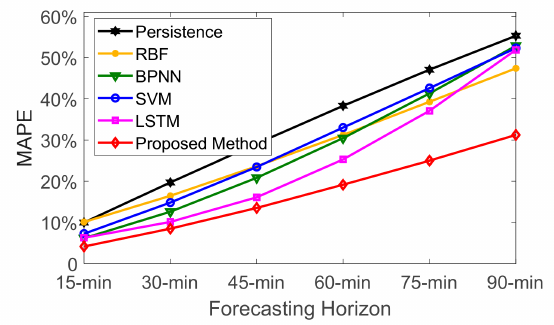
Figure 10. Average MAPE statistics for case 1 and case 2 in terms of various forecasting